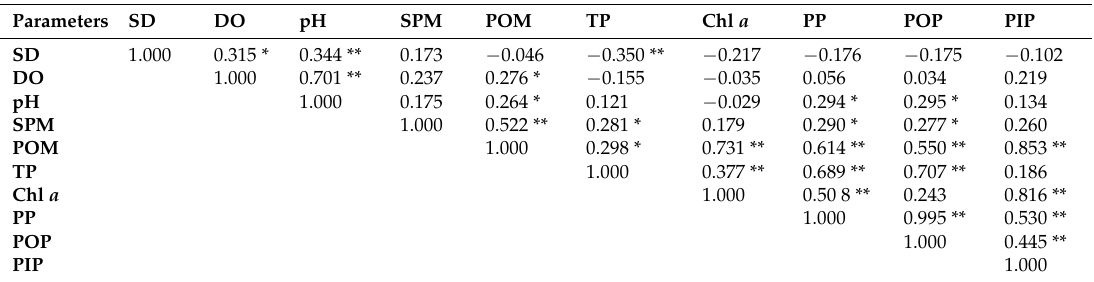
Table 2. Correlation between different particulate phosphorus and environmental